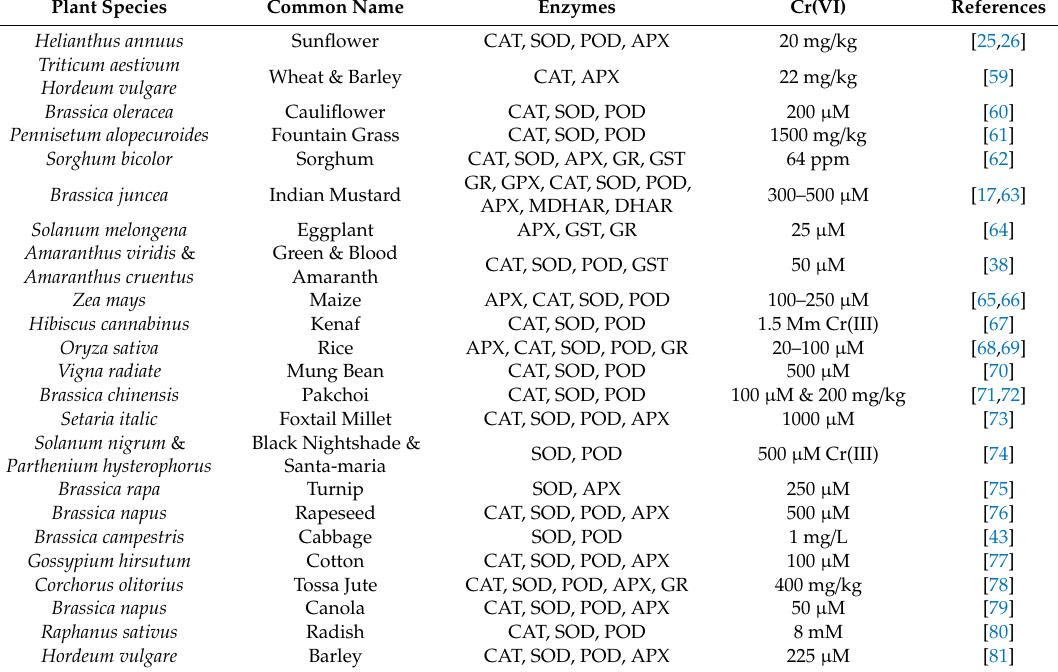
Table 2. Chromium-modulated antioxidant enzymes in various plant species. Ascorbate